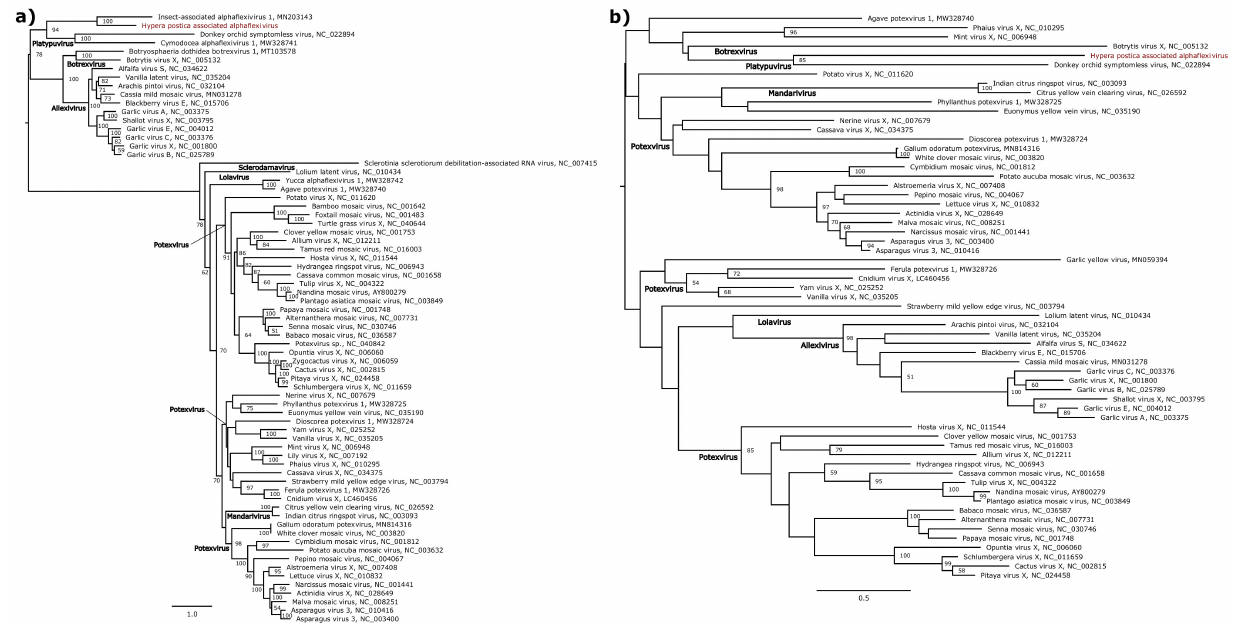
Figure 5. Maximum likelihood phylogenetic tree based on ( a ) the RNA-dependent RNA polymerase protein of 71 alphaflex- iviruses, and ( b ) on the capsid protein of 61 alphaflexiviruses. The virus reported in this study is marked in red. The tree was mid-point rooted. Bootstrap values (100 replicates) superior to 50% are indicated at each node. Scale bar corresponds to amino acid substitutions per site.